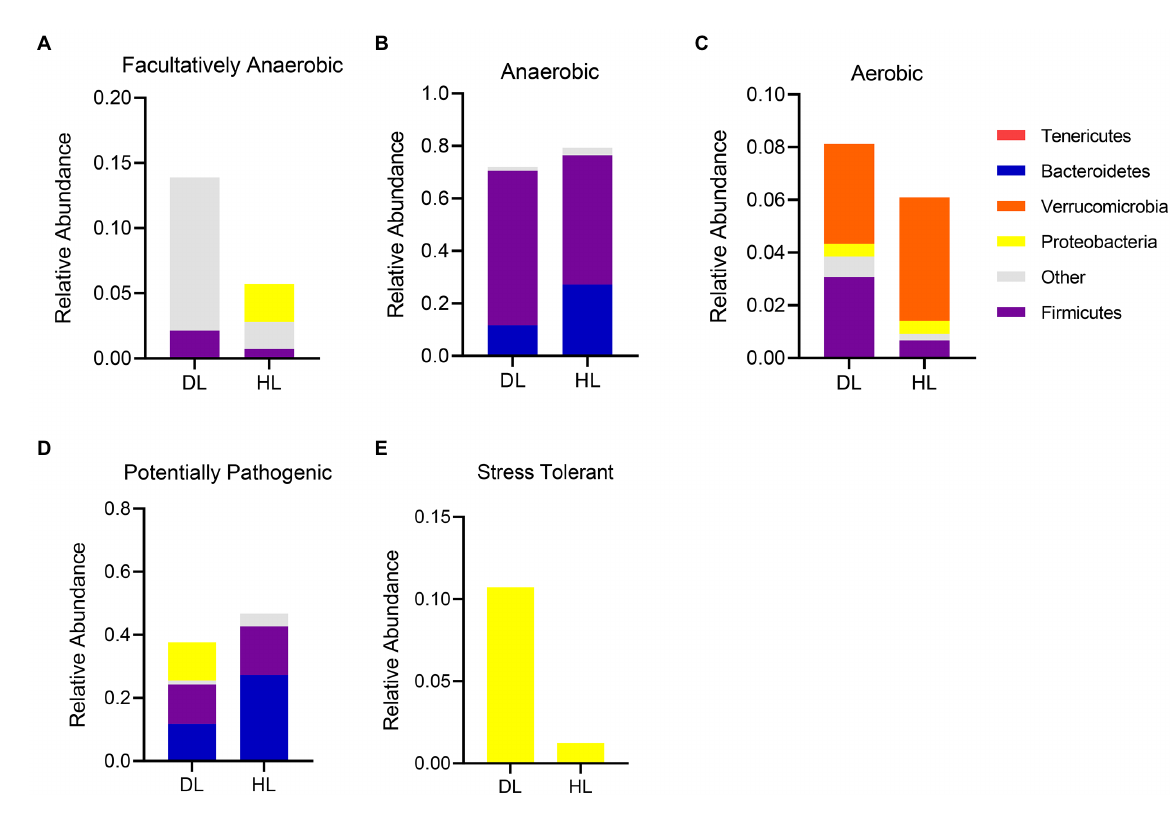
FIGURE 4 BugBase functional analysis of intestinal microbiota in each group. (A) Facultative anaerobe compositions in each group. (B) Anaerobic bacteria compositions in each group. (C) Composition of aerobic bacteria in each group. (D) Composition of Potentially Pathogenic in DL and HL group. (E) Composition of Stress Tolerant in each